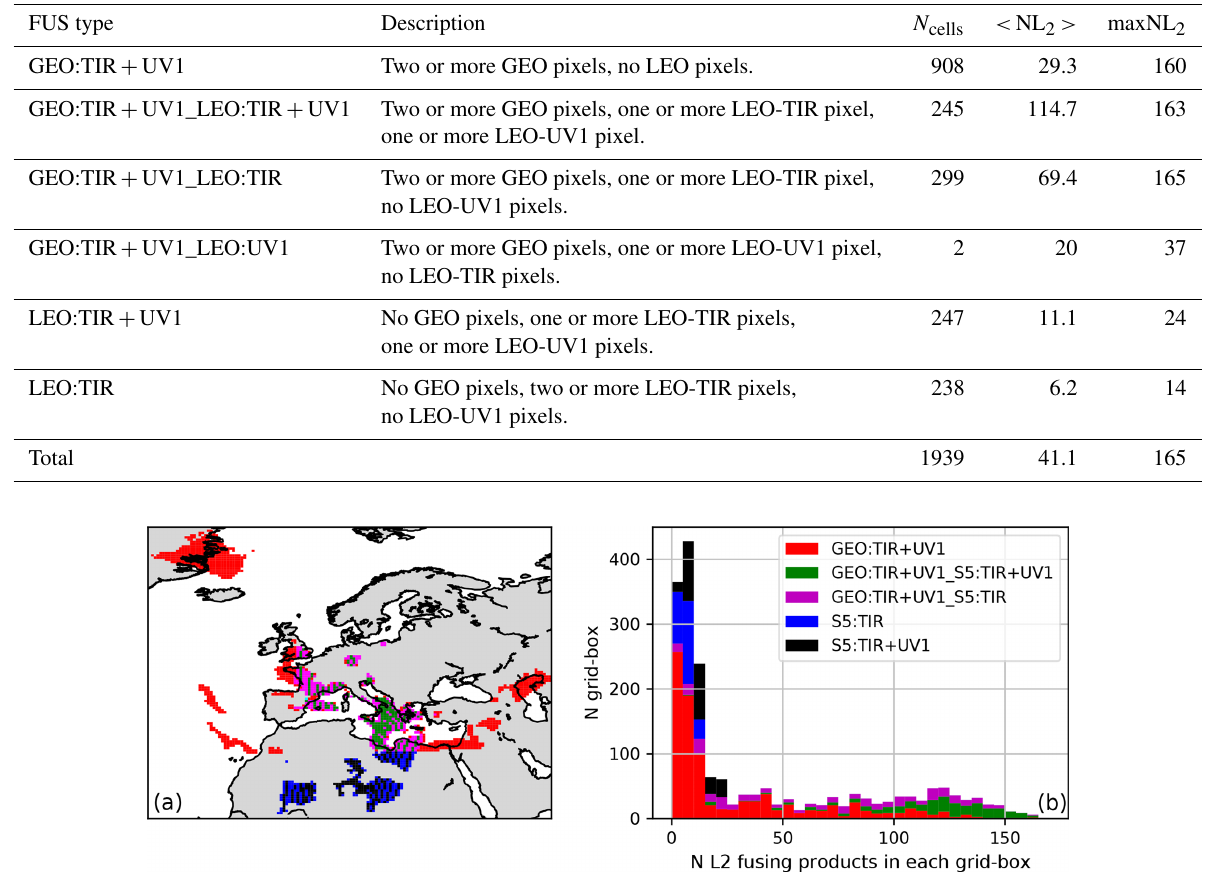
Table 3. Types and characteristics of the fused product when a coincidence grid cell size of 0.5 ◦ × 0.625 ◦ is used. N cells is the number of grid boxes characterized by the considered FUS type, < NL 2 > is the mean number of individual L2 fusing profiles per grid box and maxNL 2 is the maximum number of individual L2 fusing products per grid box.